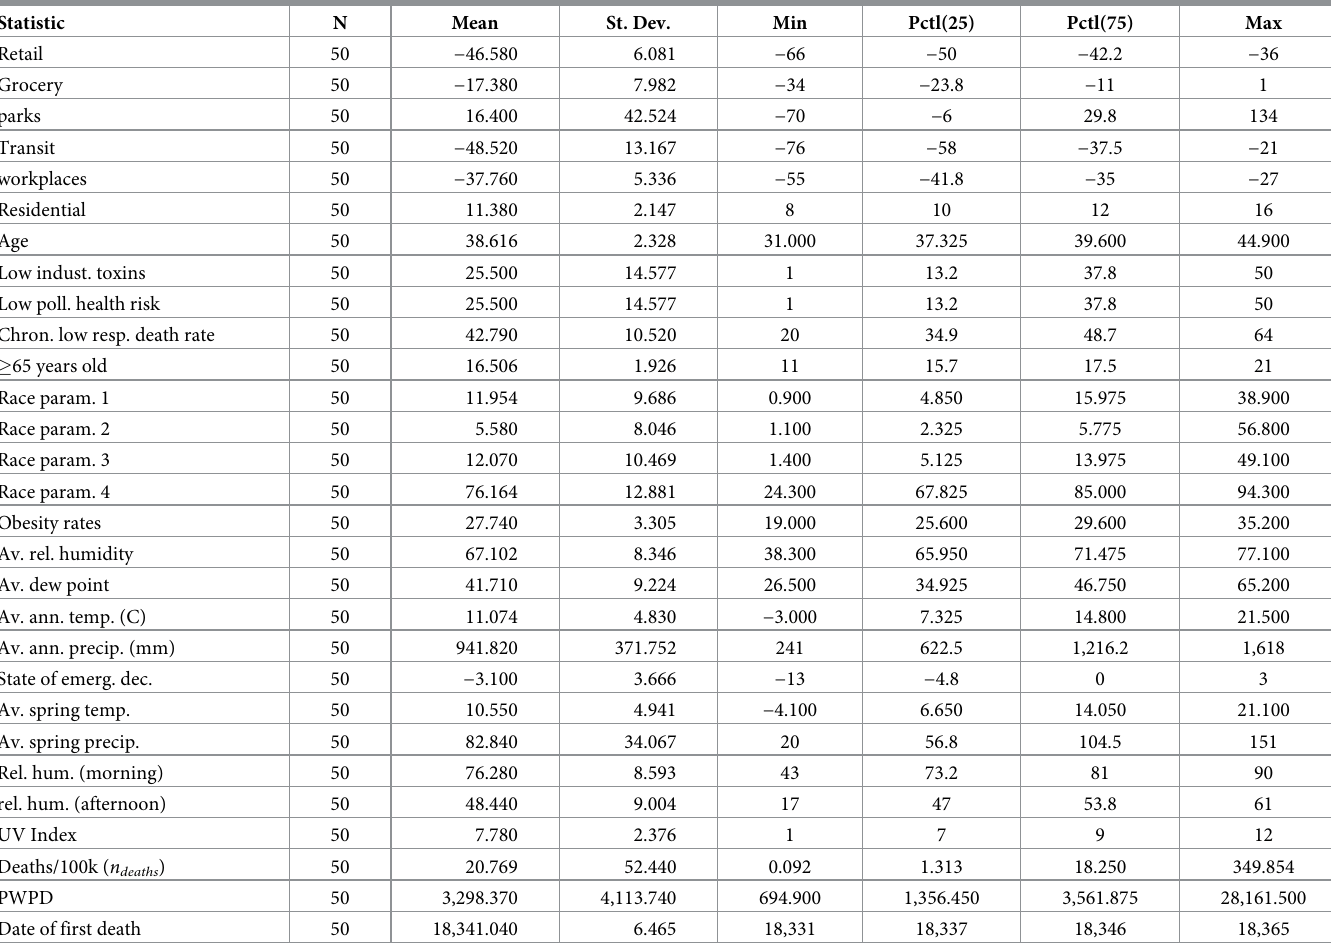
Table 1. List of parameters used in multiple-regression analysis, together with their basic statistical properties. See text for detailed explanation of each parameter. Statistic N